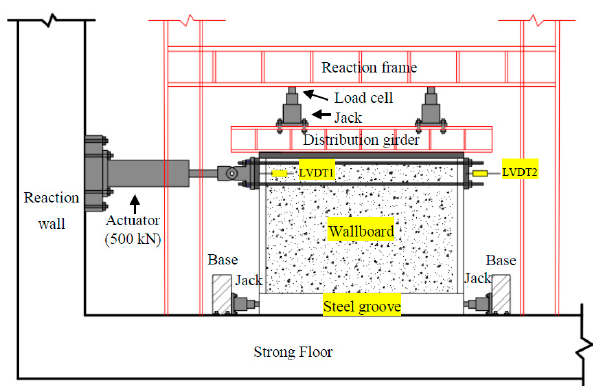
Figure 4. Overview of the test setup and instrumentation.